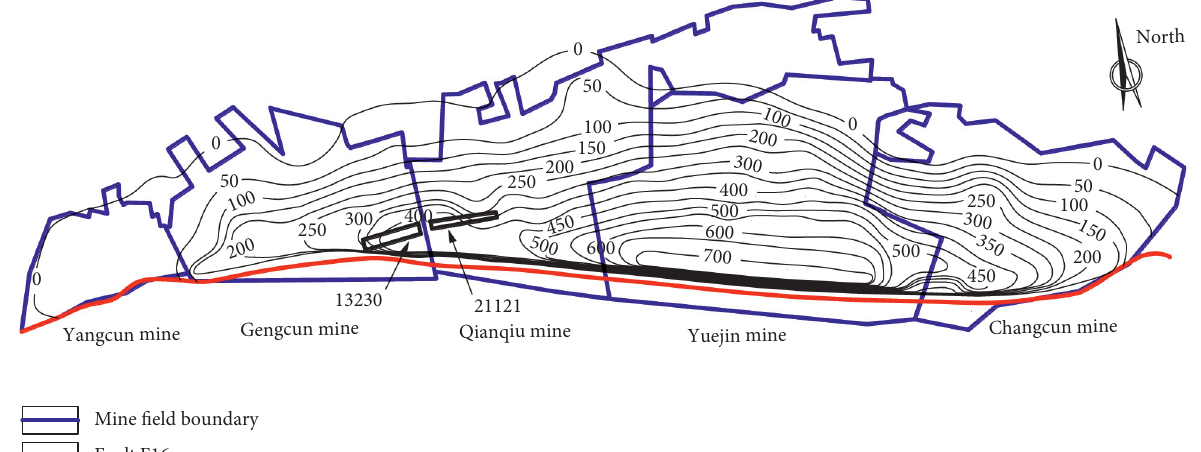
Figure 2: Thickness distribution of conglomerate in Yima mining area.